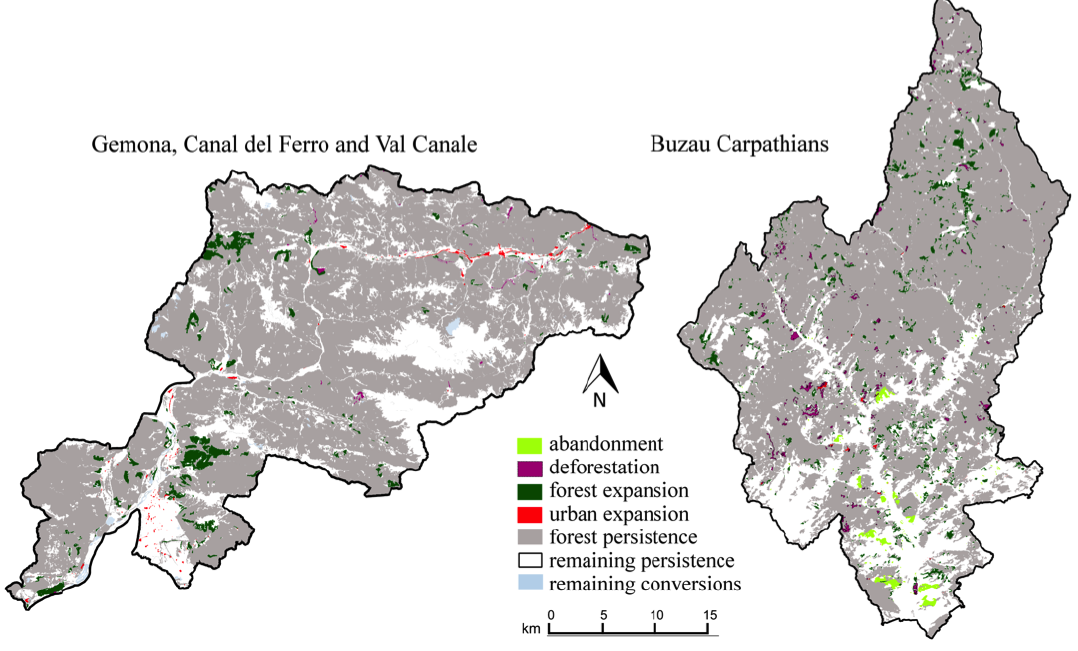
Figure 3. Spatial distribution of land cover conversions between 1989 and 2010. See Table 4 for the conversion definition and Table 6 for the estimations of the accuracy and areas. Remaining persistence and conversion present land cover persistence or conversion other than described by abandonment, deforestation, forest and urban expansion and forest persistence.